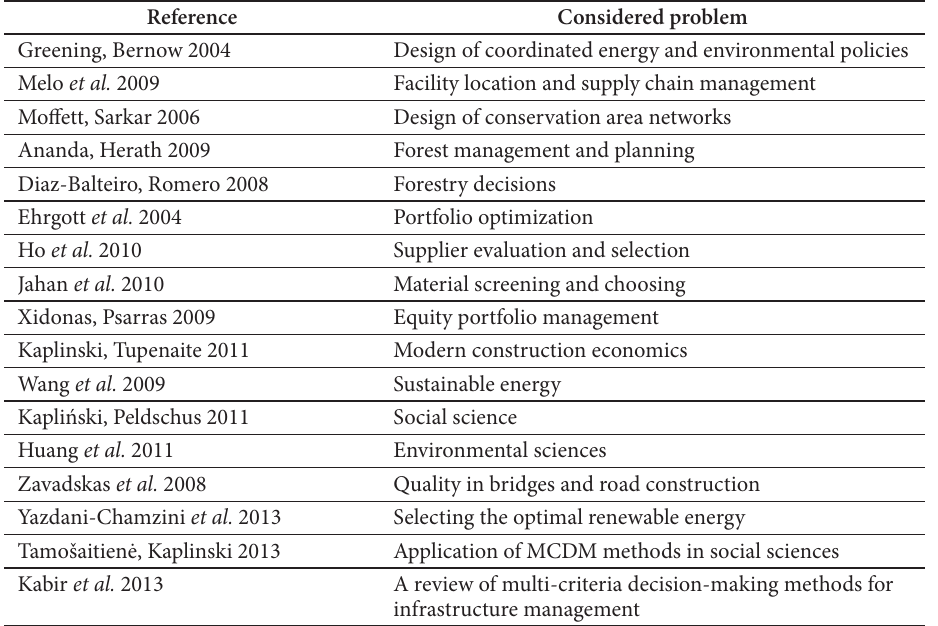
Table 6. MCDM review on topics of individual